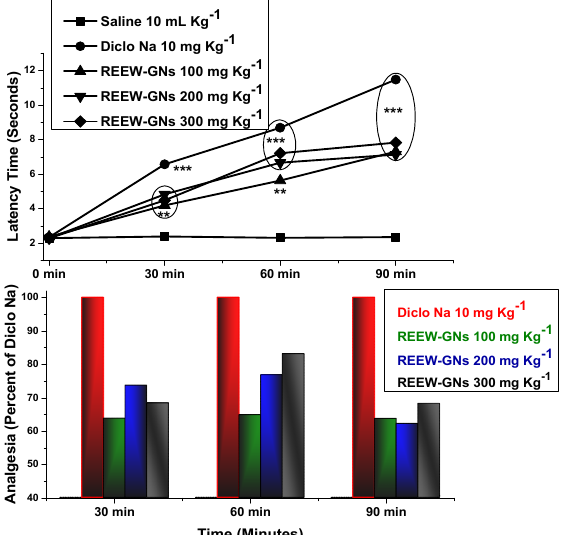
Figure 10. Analgesic effect of various doses of REEW-GNs at different time intervals: latency time (seconds) is represented as mean ± SEM of n = 6 at p < 0.05. OWANOVA revealed significant to highly significant elevation in latency time compared to saline. ** and *** represent highly significant effect compared to saline ( p < 0.01), * represent signi fi cant e ff ect ( p ˂ 0.05) where NS represent sta- tistically non-signi fi cant di ff erences among the treatments.